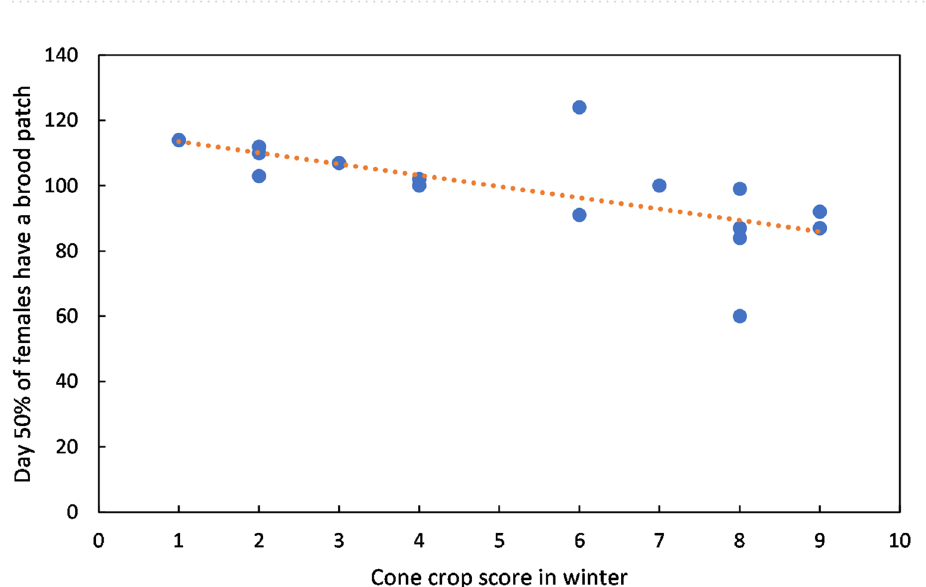
Figure 3. Cone crop impact on timing of brood patch formation. Day of year on which 50% of female siskins had brood patches in relation to cone crop score of previous winter. Data for 2005–2020. R 2 =